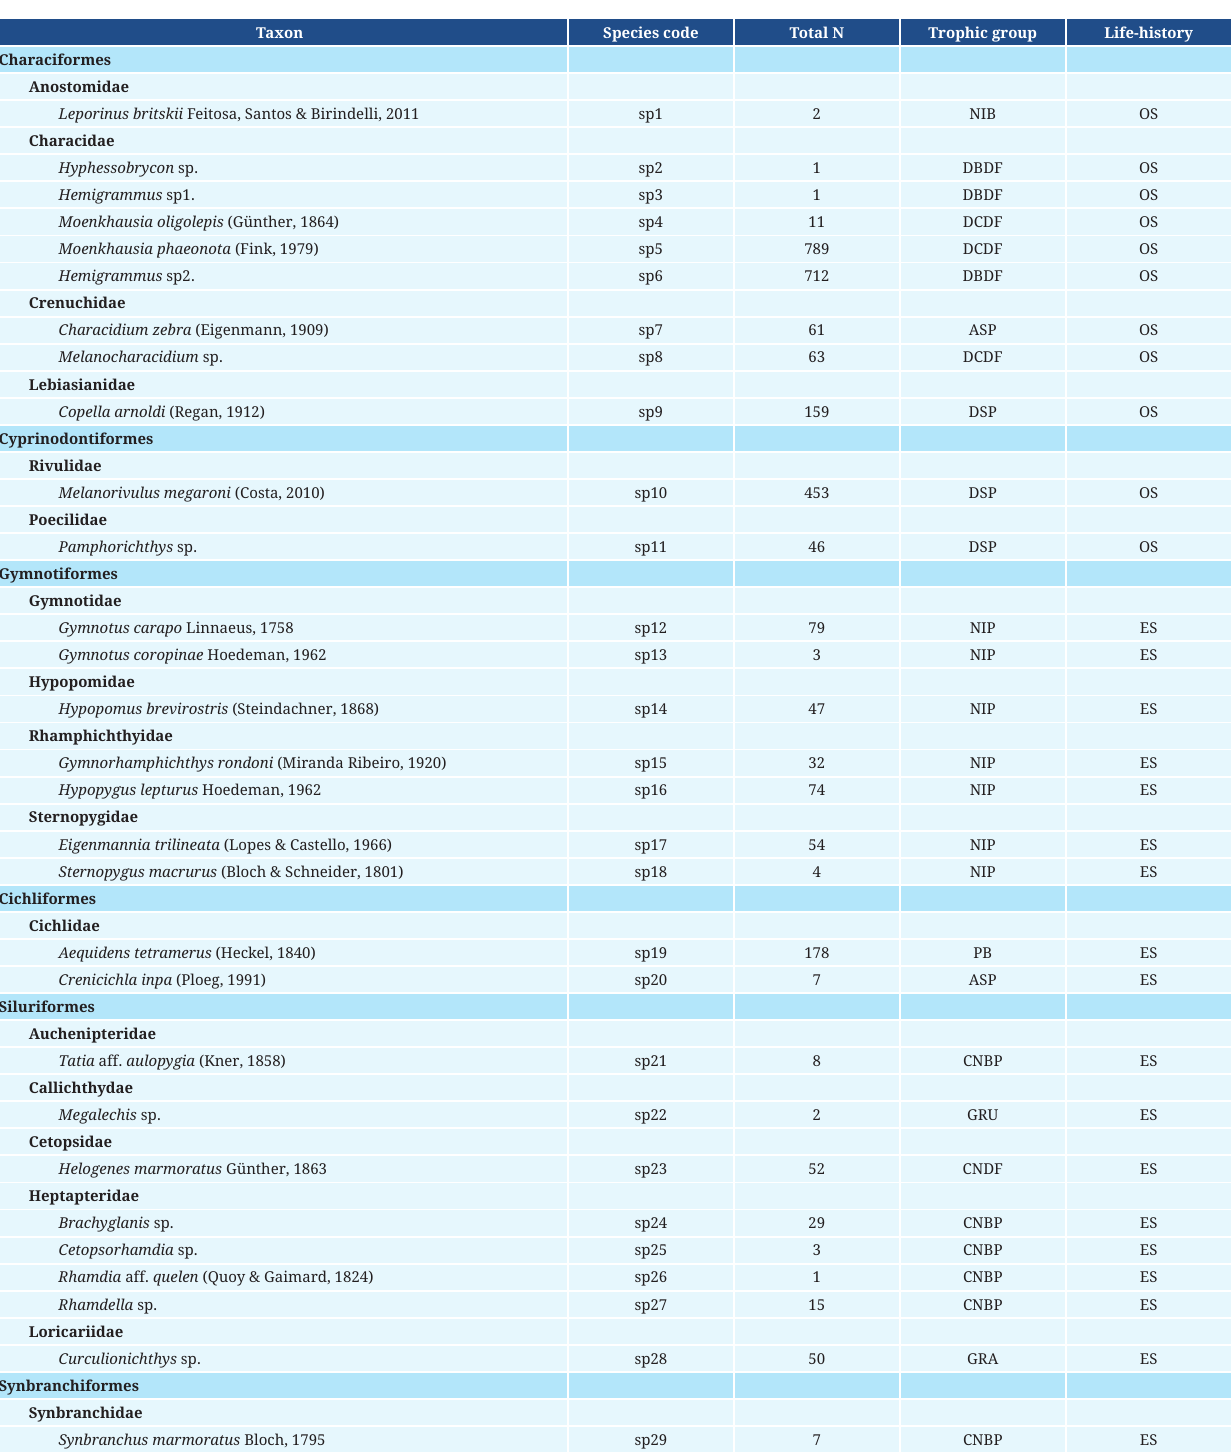
TABLE 3 | Species list classified according to their trophic functional groups and life history. Species found in nine streams sampled in 2017, in the Tanguro Farm, Municipality of Querência, state of Mato Grosso. NIB: Nibblers; DBDF: Diurnal backwater drift feeders; DCDF: Diurnal channel drift feeders; ASP: Ambush and stalking predators; DSP: Diurnal surface pickers; NIP: Nocturnal invertebrate pickers; PB: Pickers and browsers; CNBP: Crepuscular to nocturnal bottom predators; GRU: Grubbers; GRA: Grazers; CNDF: Crepuscular to nocturnal drift feeders; OS: Opportunistic strategy; ES: Equilibrium Taxon Species code